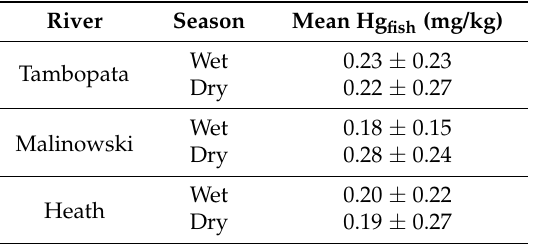
Table 1. Number of oceanic sea skaters, Halobates , collected at locations in the tropical Pacific Ocean on 7–8 December2016,during the science cruise, MR16-08 (N: total number of individuals collected; H.g.: Halobates germanus , H.m. : H. micans ; Stat: station number; WT: water temperature (°C); AT: air temperature; L: number of larvae; A: number of adults, E: number of exuviae; EG: number of eggs (on substrates such as polystyrene form); Date: sampling date; Sampling was performed for 15 min; Sa: salinity (‰); S: surface area swept by the neuston net expressed as the value of the flow-meter × 1.3 m 2 of the width of the neuston net; WS: wind speed (m/s); W: weather; TD: time of day; CS: current speed (m/s); CD: current direction; F: female; M: male. No other species of oceanic sea skaters was collected in this area.